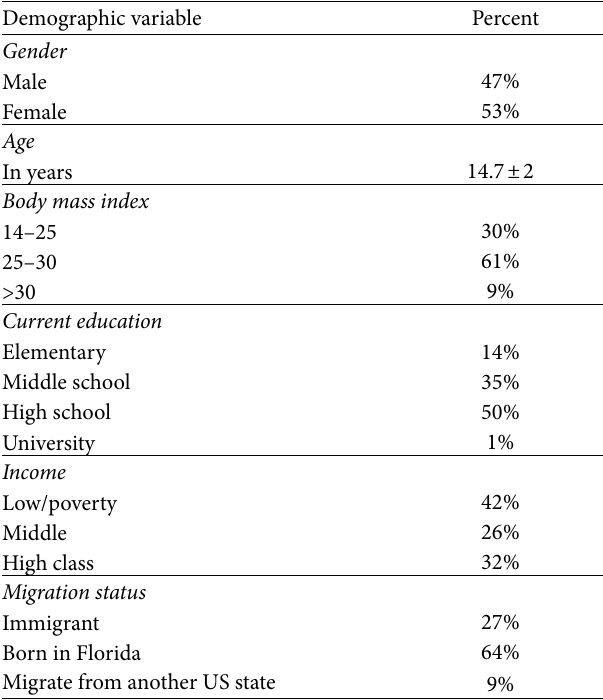
Demographic characteristics of the total group expressed as percentages from all 500 participants from the ROBIM